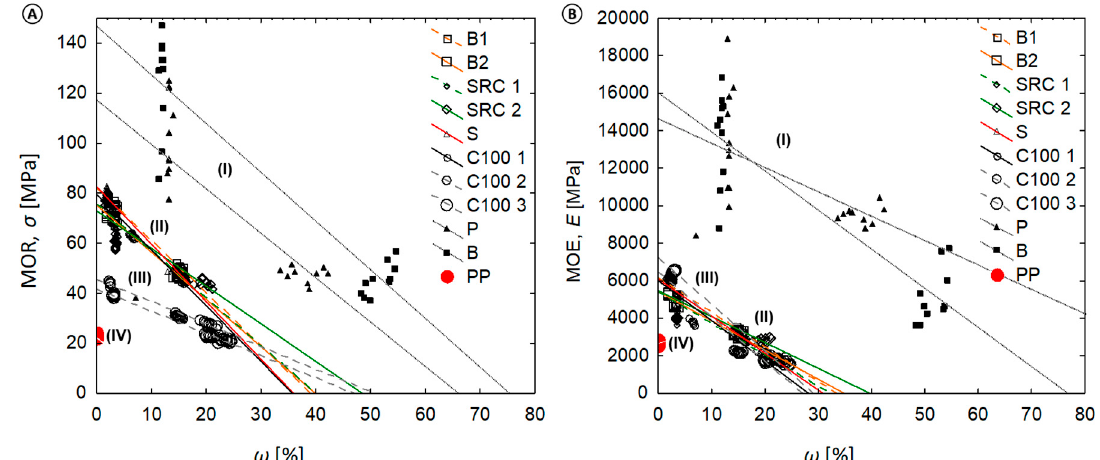
Figure 6. Relationship between material moisture content ( ω in %) and ( A ) MOR and ( B ) MOE. Note that the following clusters of material classes became evident. (I) wood (P, B)—Strong to weak negative correlation, high variation of individual data values; (II) WPC with MAPP—Strong to moderate negative correlation; narrow variation of data values; (III) WPC without MAPP—Strong negative correlation, narrow variation of data values; (IV) pure polypropylene—No correlation, very low variation of data values.